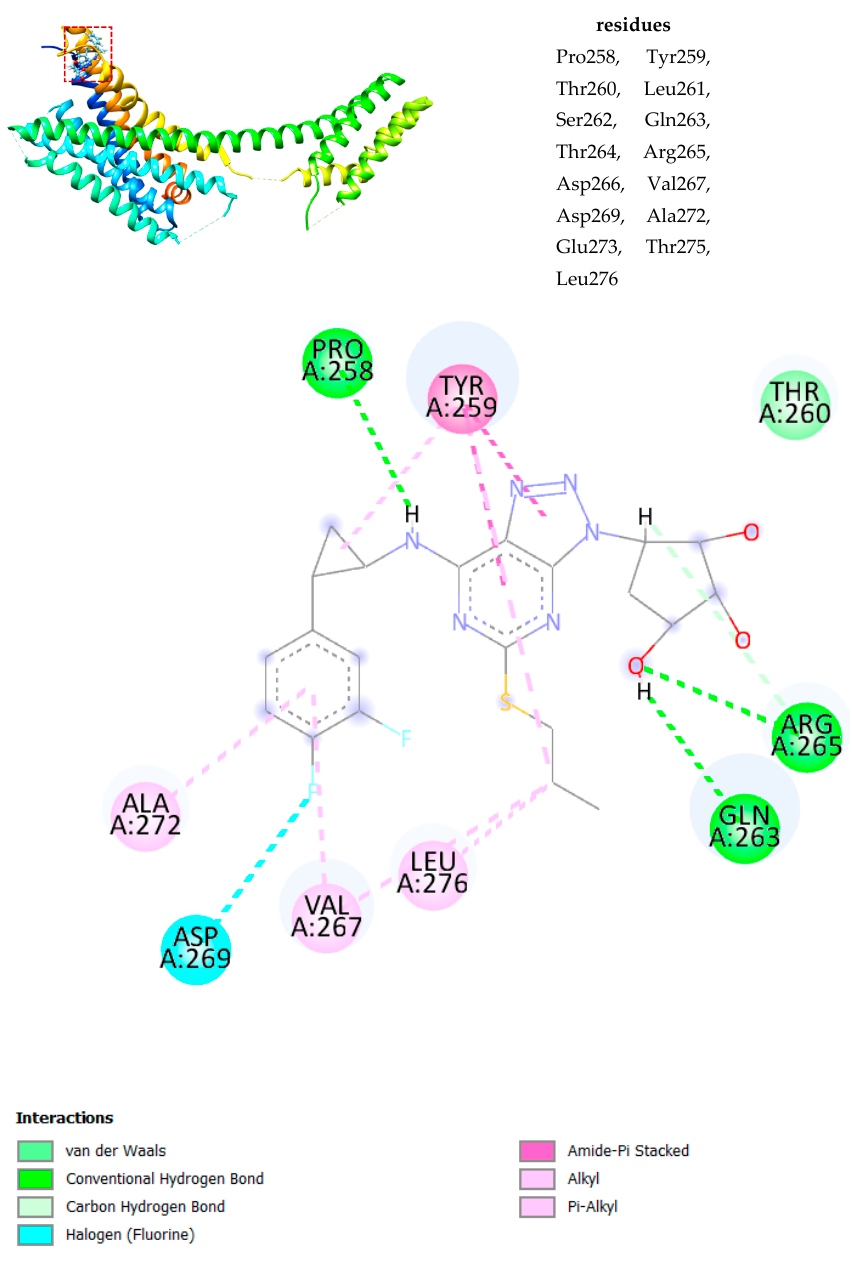
Figure 4. The molecular docking model of ticagrelor AM in the binding site of P2Y 12 .